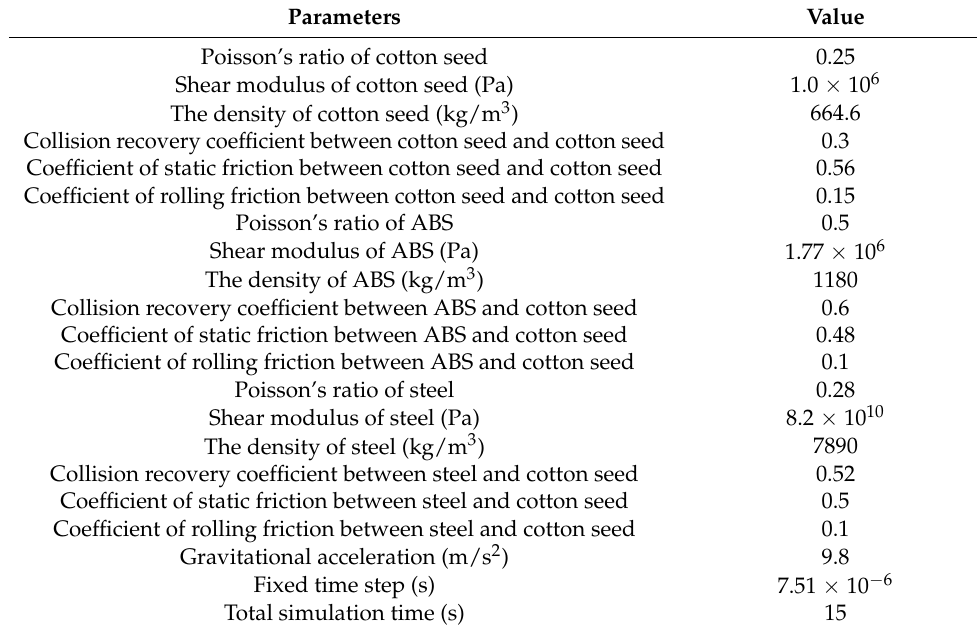
Table 1. Parameters used in the DEM